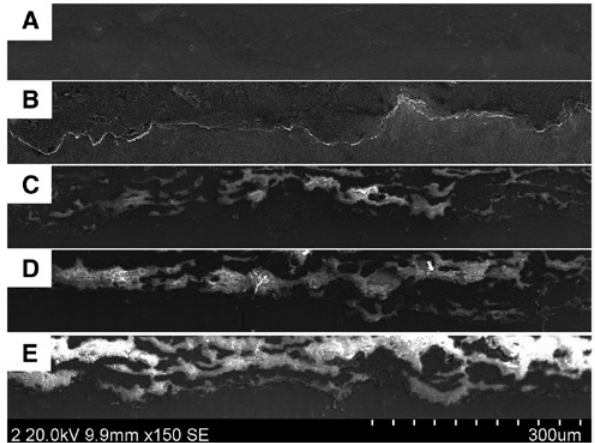
Figure 5 Higher magnification view of Al